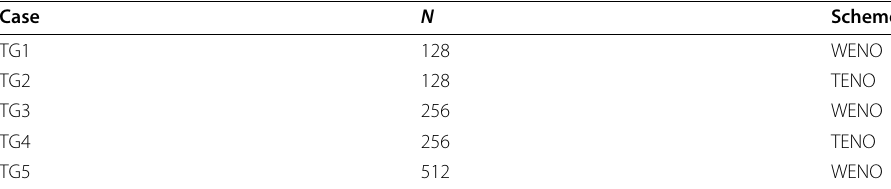
Table 2 TG cases for testing numerical